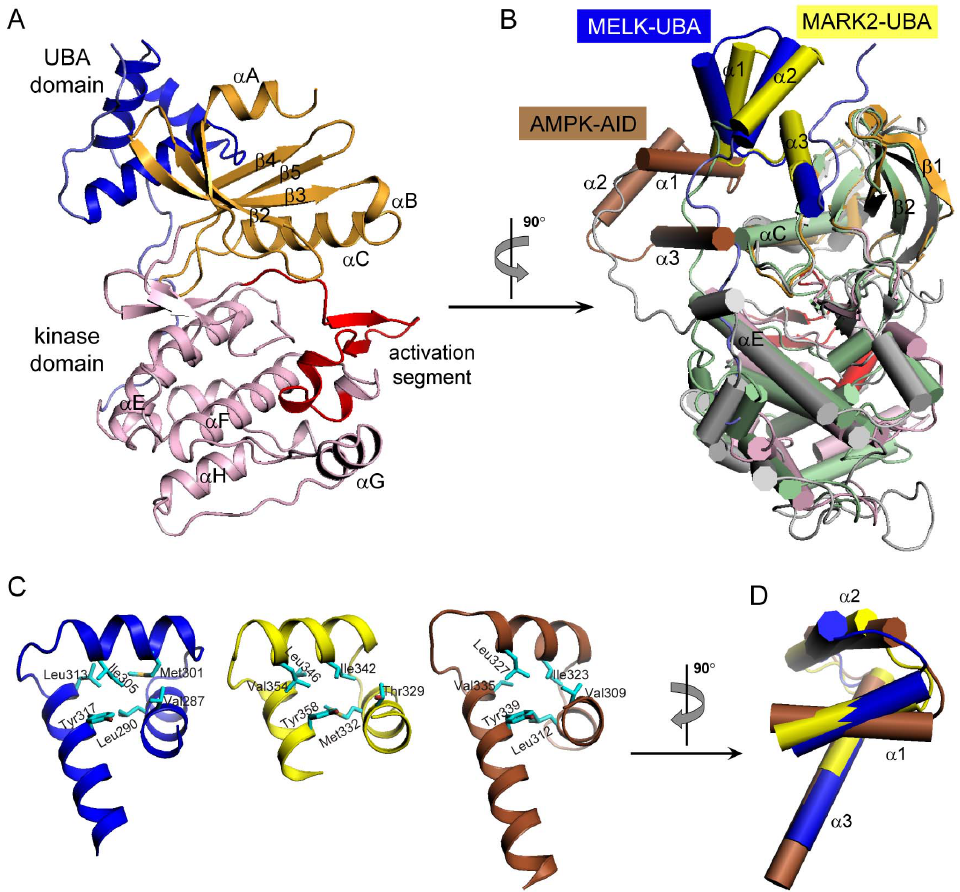
Figure 2. Overall Structure of MELK KD-UBA. (A) Ribbon representation of MELK KD-UBA using the identical coloring scheme as in the schematic diagram in Figure 1A. All structural representations were prepared with PyMOL (http://www.pymol.org). (B) Structural comparison of MELK KD-UBA with MARK2 KD-UBA (2WZJ) and AMPK KD-AID (3H4J) upon superposition of the N-lobes of their kinase domains. The kinase and UBA domains of MARK2 are respectively shown in light green and yellow, and the corresponding domains of AMPK KD-AID in gray and brown. (C) Conserved hydrophobic cores of MELK-UBA, MARK-UBA and AMPK-AID. The hydrophobic residues are highlighted as cyan sticks. (D) Difference in the helix arrangement of three UBA domains from MELK, MARK and AMPK upon superposition of their a 3